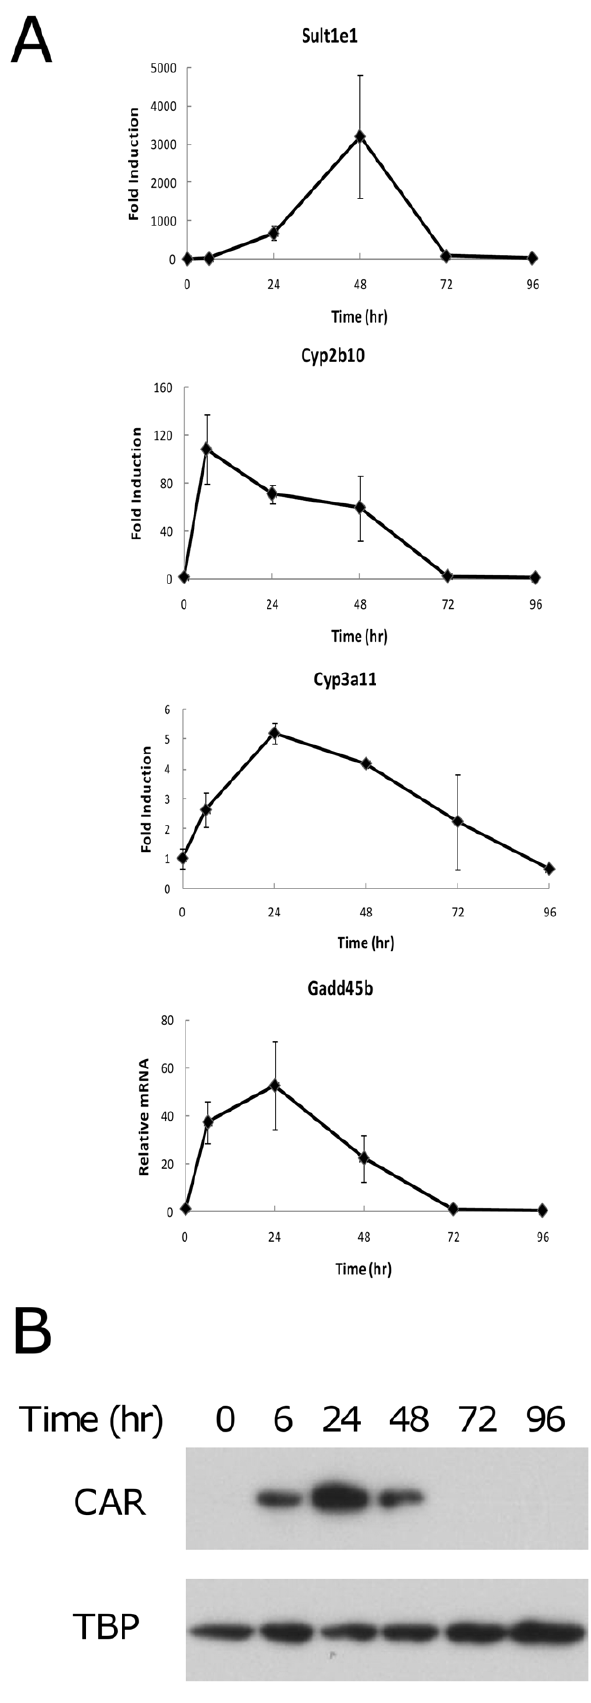
Figure 3. Gene induction time course. (A) Wild type and Car null mice were given DAS (80 mg/100 g body weight) by gastric gavage. B. Following 6, 24, 48, 72, and 96 hrs after chemical administration, the expression of Sult1e1 , Cyp2b10 , Cyp3a11 , and Gadd45b genes was analyzed by quantitative PCR as described in the methods section. The relative mRNA amount of each gene was calculated so that wild type vehicle treated samples have one unit of expression. (B) Liver nuclear extracts from DAS treated mice at indicated time after the chemical administration were prepared and CAR protein content was analyzed by western blotting. Anti TATA binding protein (TBP) western blotting is shown as a loading